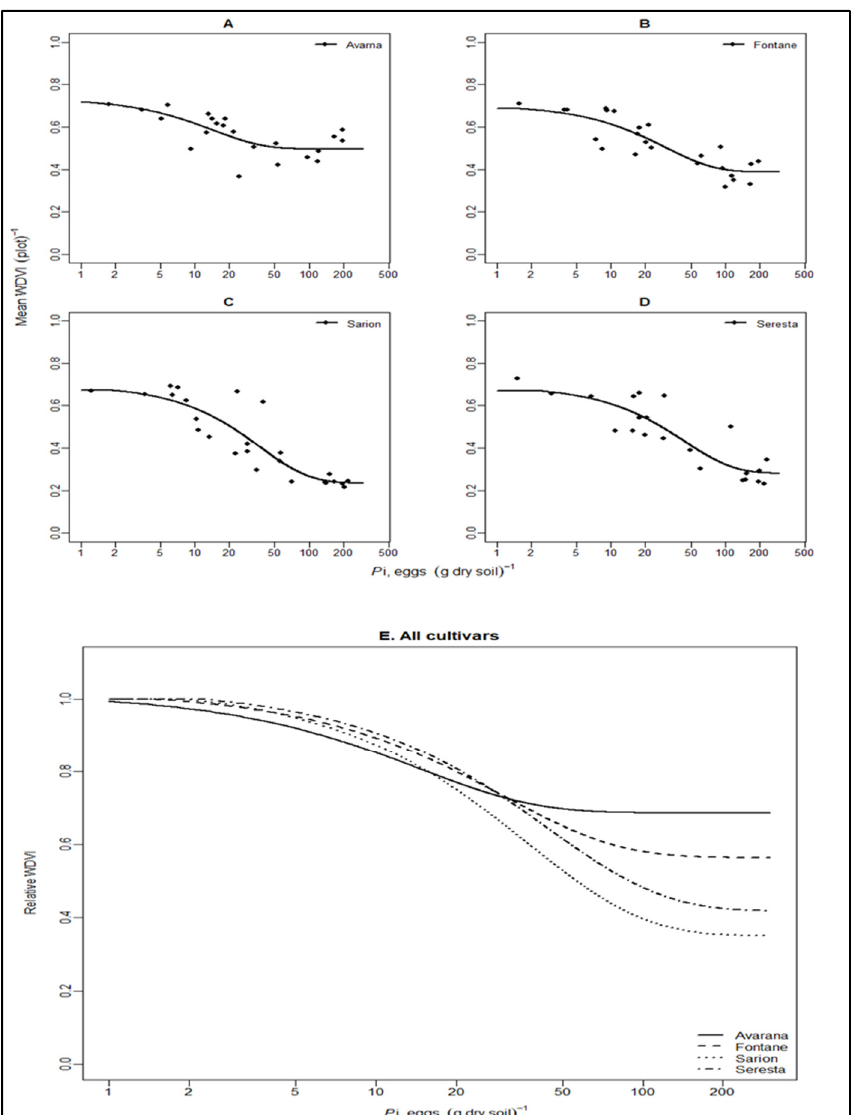
Figure 5. Relationship between the P i, eggs (g dry soil) − 1 and the WDVI index of four potato cultivars according to Seinhorst Yield model Equation (1). (( A ) Avarna. ( B ) Fontane. ( C ) Sarion. ( D ) Serresta.) ( E ) Relative WDVI of all the cultivars combined.